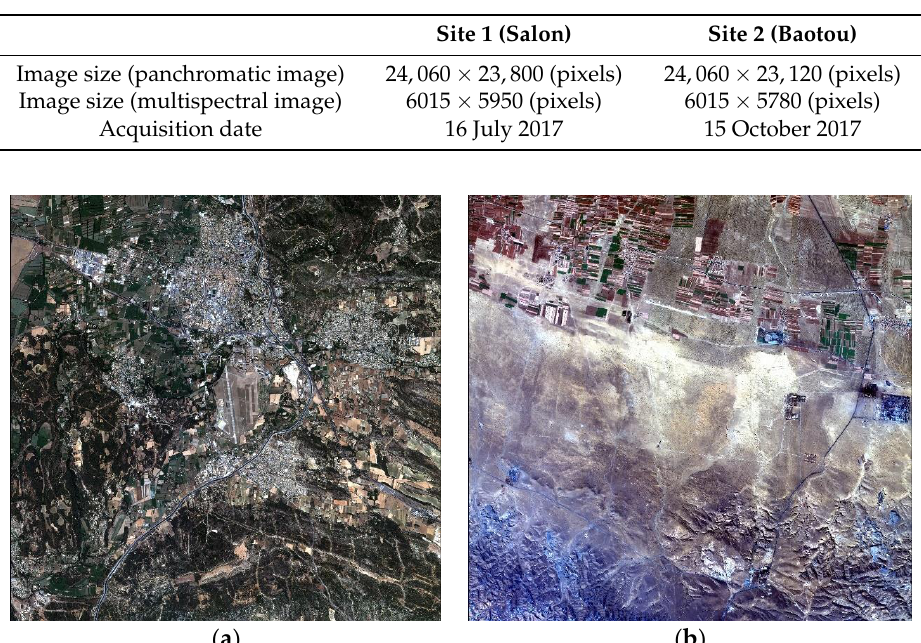
Table 2. Descriptions of the experimental datasets.